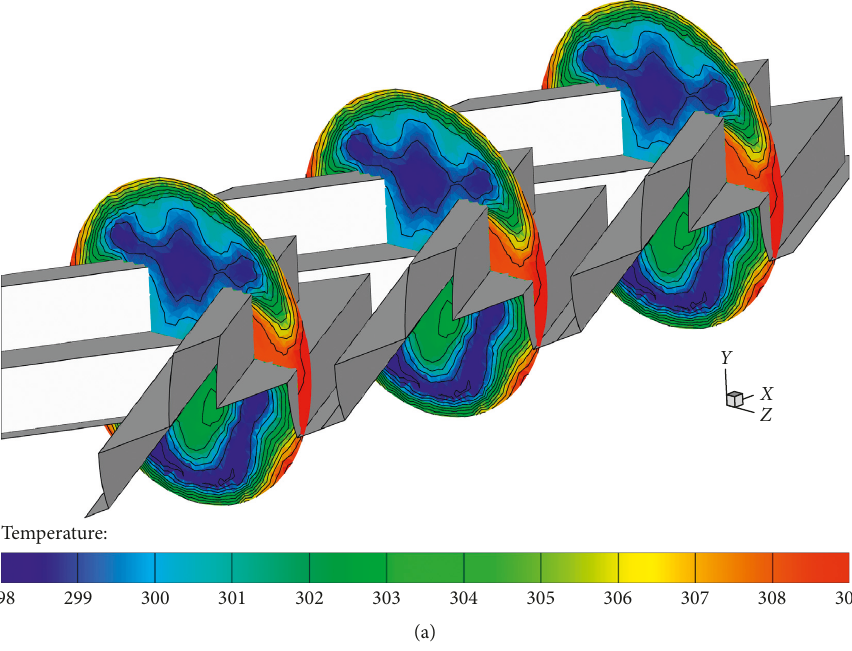
Figure 6: Longitudinal vortex flow of the heat exchanger tube inserted with the V-wavy surface at α Downstream and (b)